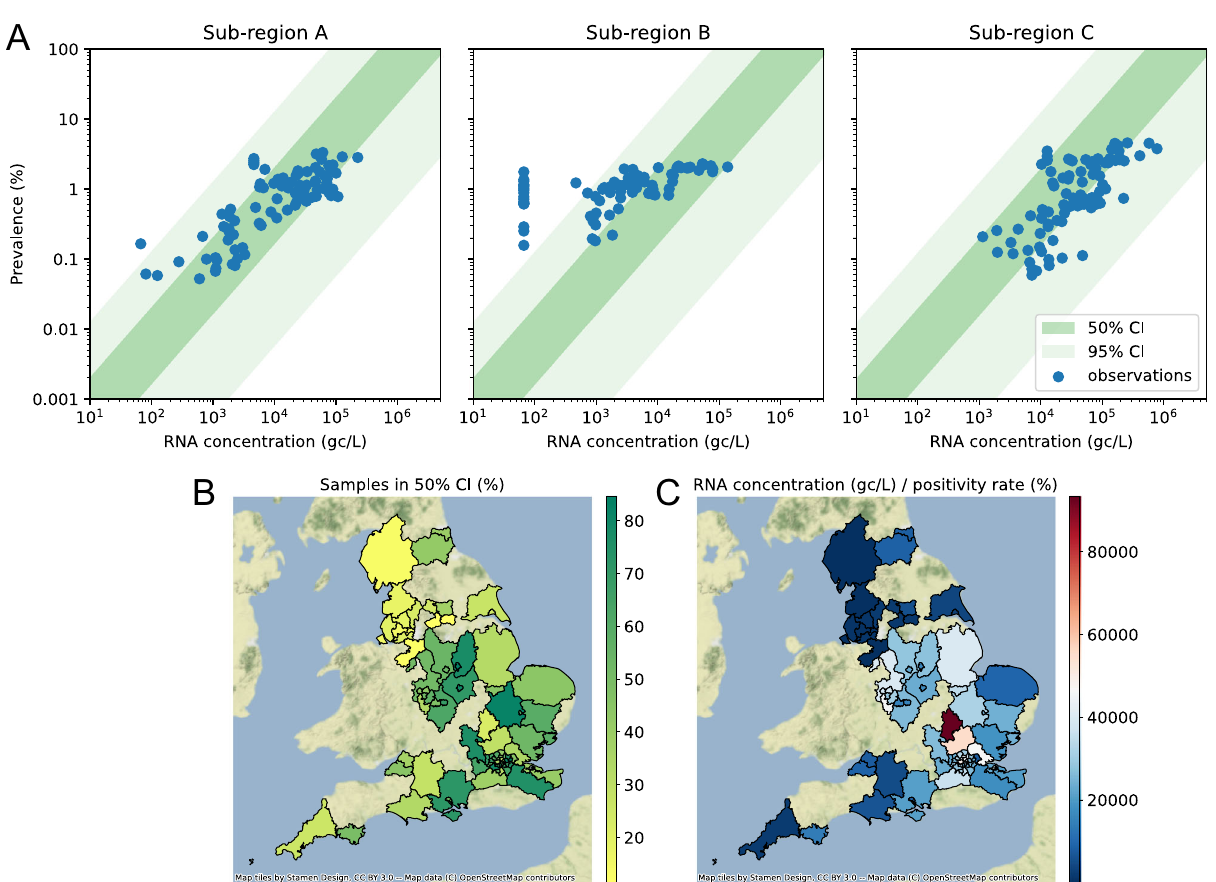
Fig. 2 Comparison of the outputs from the phenomenological model to CIS prevalence estimates. A Example fi t between the phenomenological model estimates (green region) and the wastewater and prevalence data from three CIS sub-regions (blue dots), selected to illustrate three cases: sub-region ( A ) (good correspondence), sub-region ( B ) (concentrations tend to be low), and sub-region ( C ) (concentrations tend to be high). Model estimates of prevalence from WW data are in the same order of magnitude and follow the shape of the relationship between concentrations and prevalence using distributions of likely parameter values, but con fi dence intervals are wide. The combined uncertainty in parameter values exceeds the variability seen in the data. B The percentage of data points within each sub-region that fall within the 50% credible interval of the phenomenological model. C The median concentrations per positivity rate. Only CIS sub-regions that overlap with the original 44 wastewater catchment sites are shown. Sites with a poor fi t to the model (yellow in sub-plot B ) show either relatively low (dark blue) or relatively high (dark red) concentrations in sub-plot ( C ). Sites with a good fi t to the model (dark green) tend to show intermediate concentrations (white).